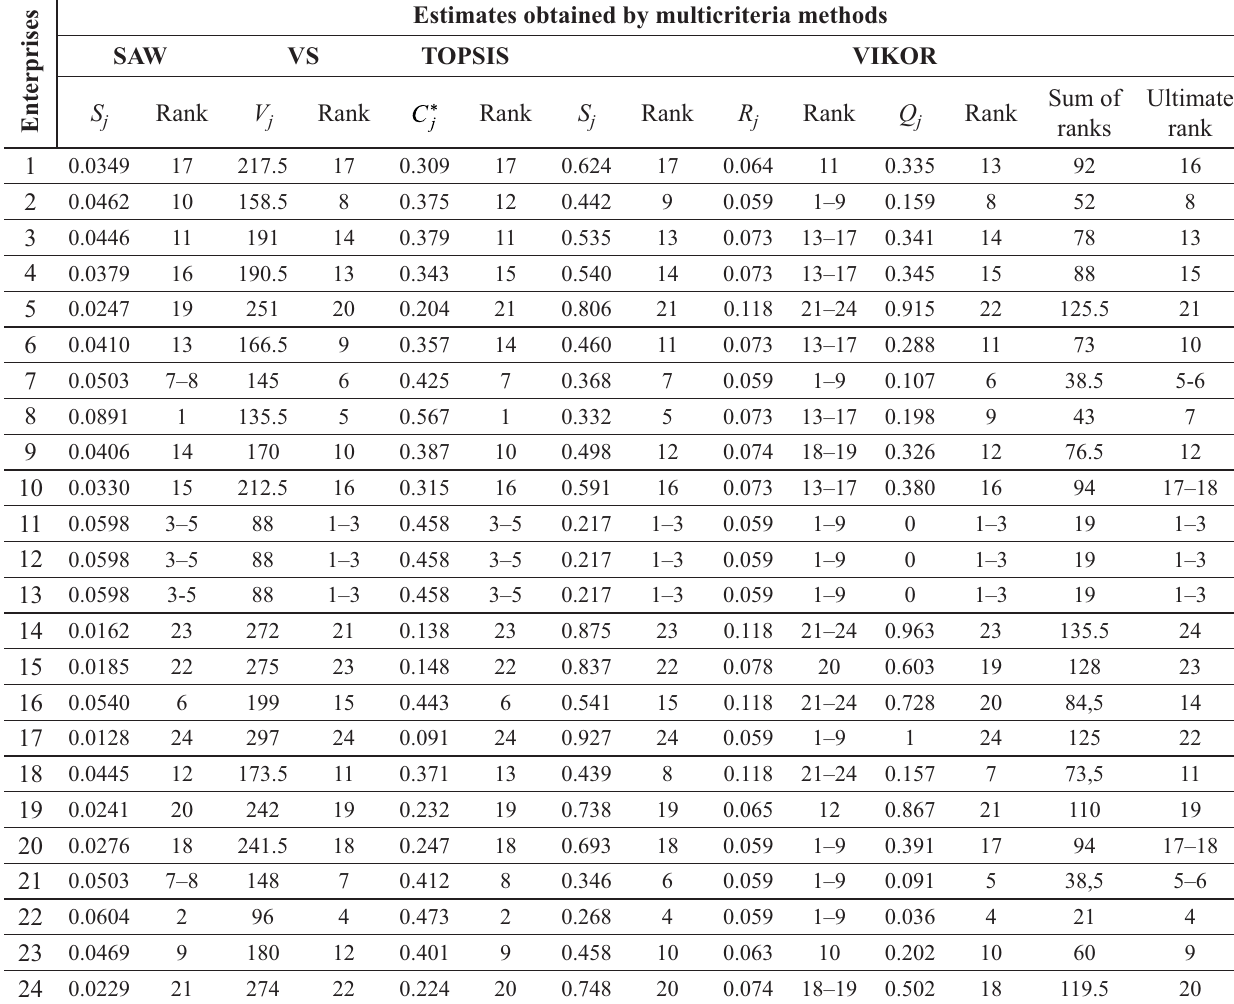
Table 8. General estimates of criteria describing aid effect obtained by multicriteria